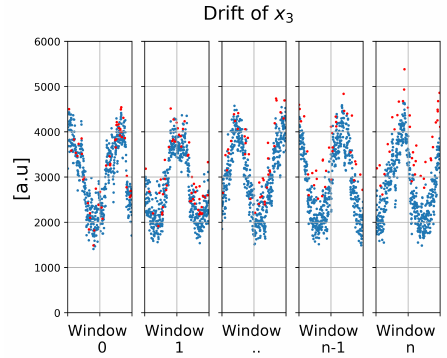
Figure 10. Sensor drift. The signal has been windowed in n segments in order to highlight the n different anomaly settings. The representation of the data in the feature subspace is not reported here for conciseness, but for obvious reasons it would be similar to the one reported in panel (c) of Figure 4 with various anomaly